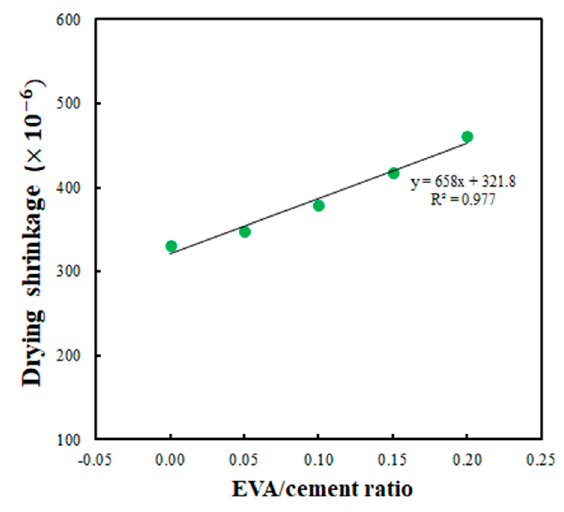
Figure 12. Relationship between EVA/cement ratio and drying shrinkage.